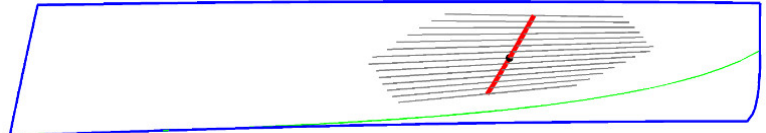
Figure 12. Contact diagram of the helical face gear without modification (a r = 0).